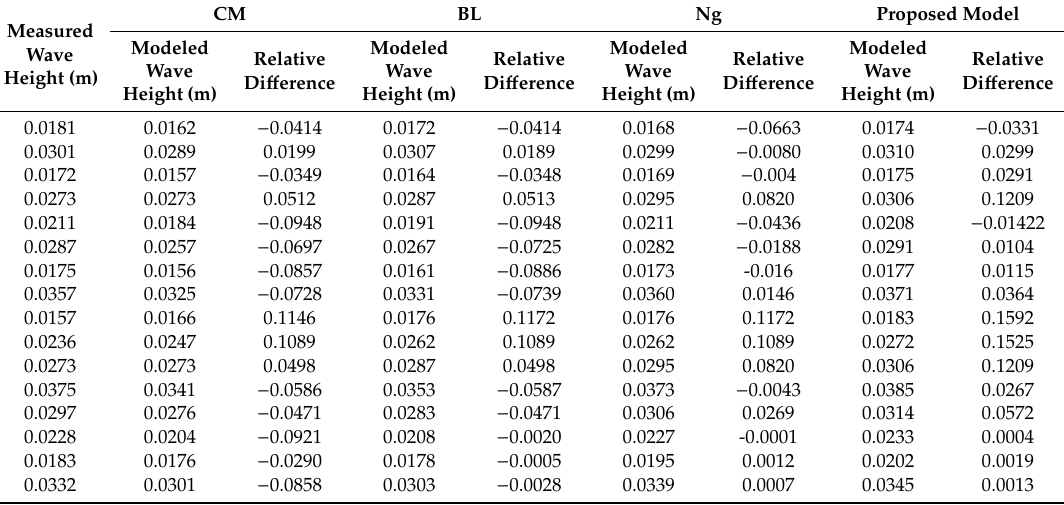
Table A1. Comparison of laboratory data and model outputs of dissipated wave height for no current